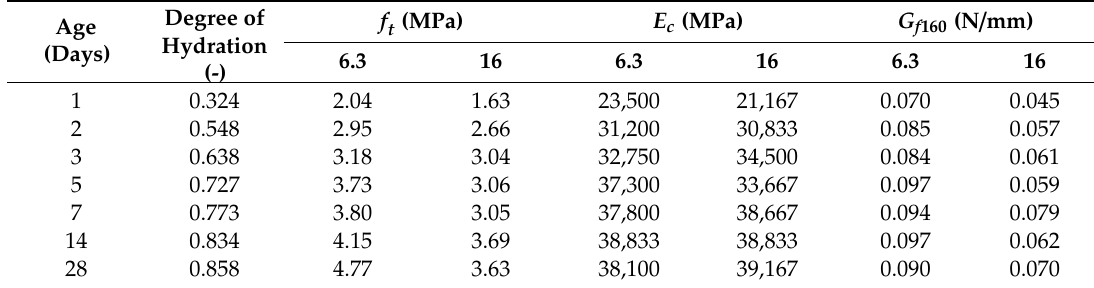
Table 3. Mean values of early age concrete properties vs. degree of hydration.